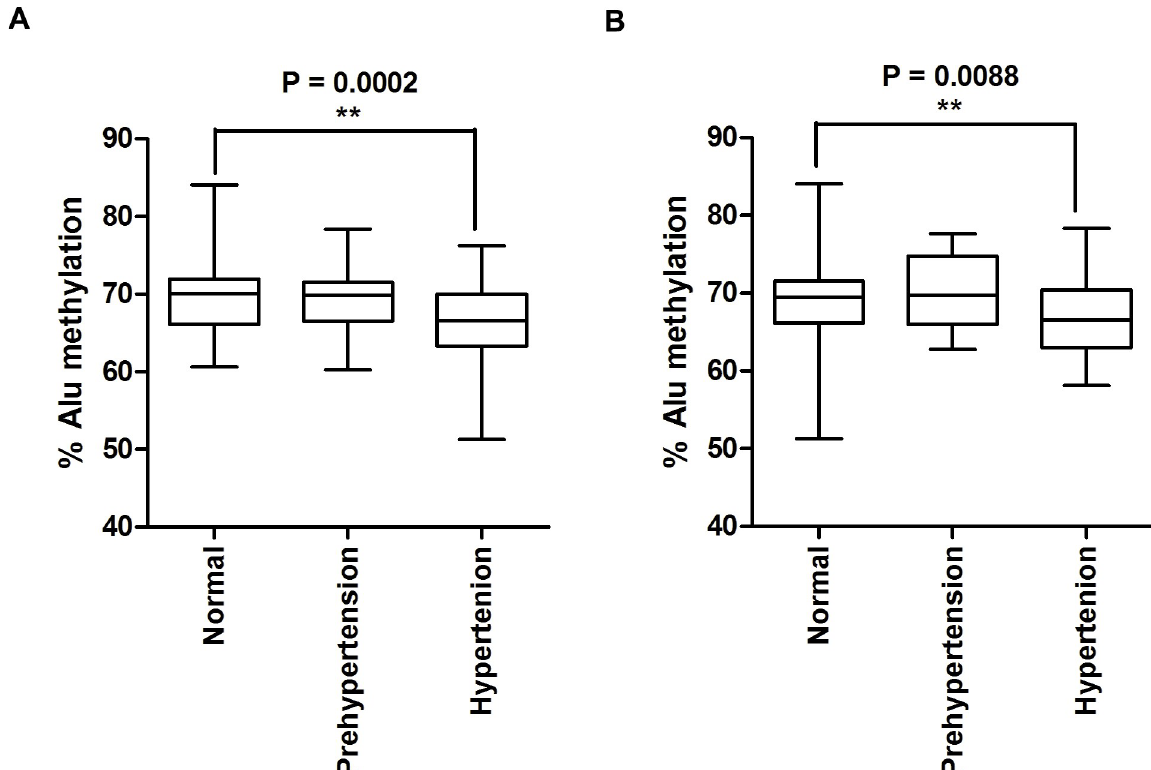
Fig 1. The percentages of the Alu methylation level in normal controls, prehypertension patients, and hypertension patients. Three groups were monitored by measuring the systolic and diastolic pressure levels. (A) The Alu methylation pattern is shown for patients grouped based on the systolic pressure level. (B) The Alu methylation show for patients group based on the diastolic pressure level. The percentages of Alu methylation are shown as box plots, with the boxes representing the interquartile ranges (25th to 75th percentile) and the median lines representing the 50th percentile. The whiskers represent the minimum and maximum values. � P < 0.05, �� P < 0.01 (t-test) (Mann–Whitney test).